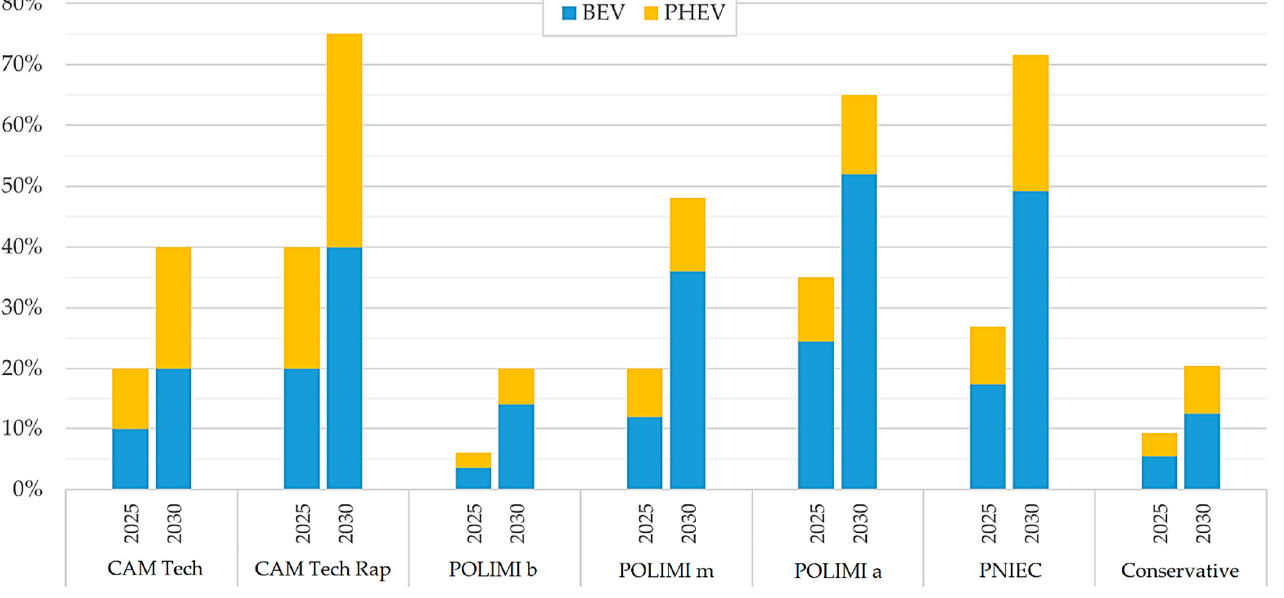
Figure 9. Comparison of estimated average penetration index on Italian car sales in 2025 and 2030, for the different sce- narios.